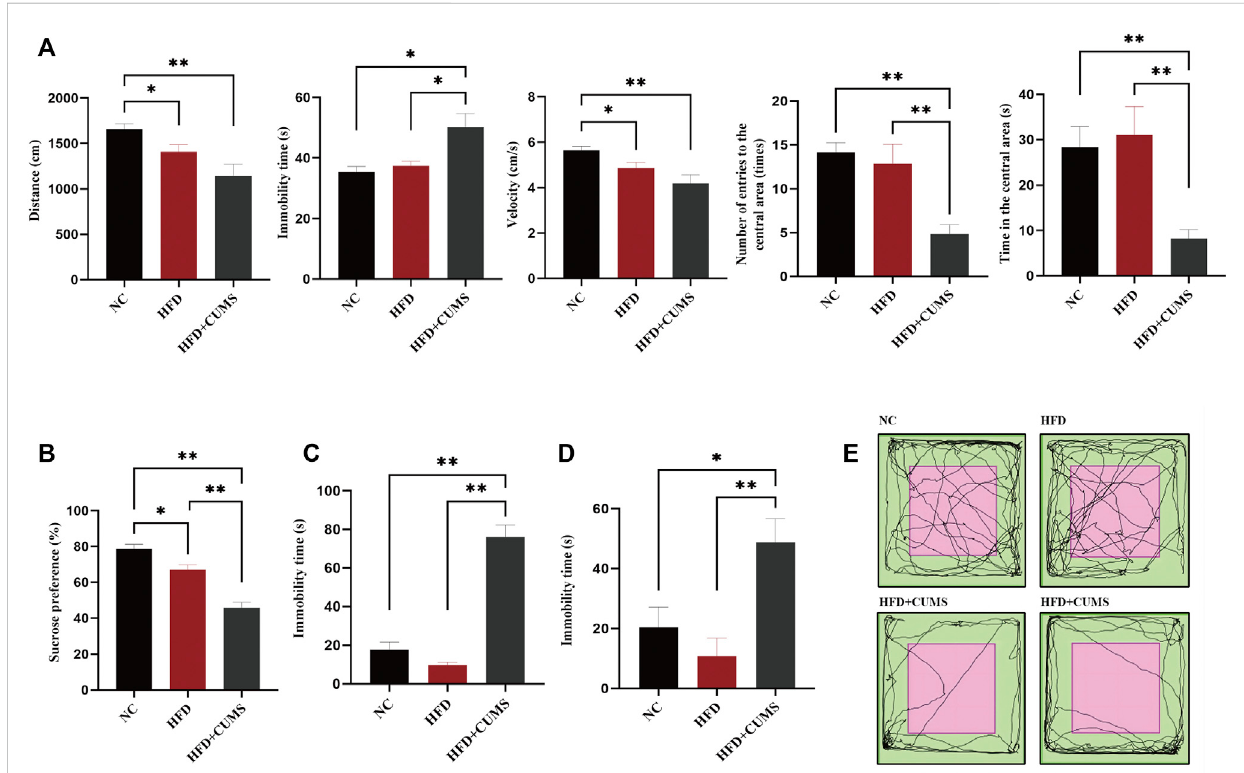
FIGURE 2 Obesity-Co-MorbidDepressionmodelwasestablishedsuccessfully ( n =8 – 9/group). (A) Locomotionactivityscores inOFT. (B) Sucrose preference in SPT. (C) Time of immobility in FST. (D) Time of immobility in TST. (E) Activity tracks in OFT. Data are shown as the mean ± SEM. * p < 0.05, ** p < 0.01 (Statistical comparisons between the two groups were performed using the two independent samples t -test. Comparisons between multiple groups were performed using One-way ANOVA and Tukey